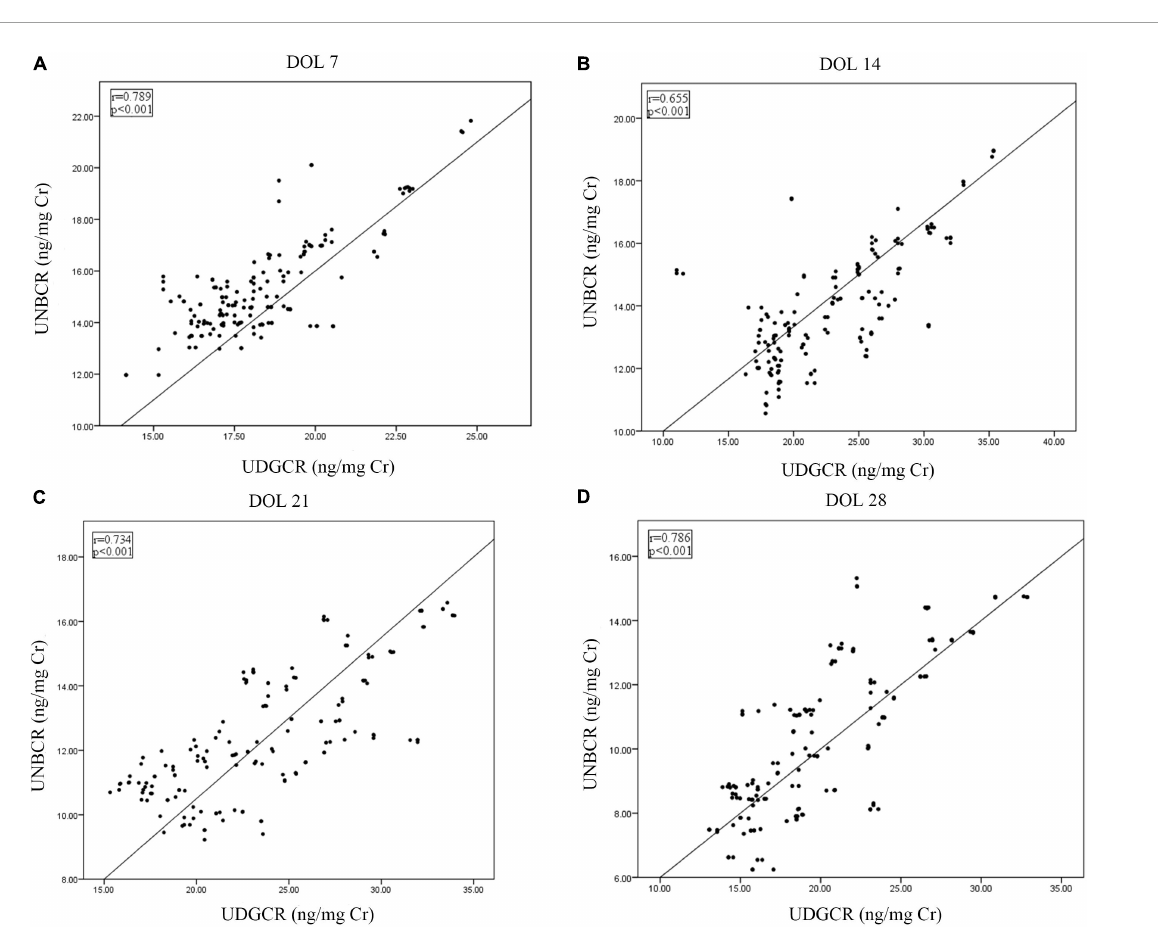
BPD. We also utilized ROC curves to determine the optimum predictive cutoff values of urine 8-OHDG and NT-proBNP for BPD from DOL 7 to DOL 28. These results may help identify preterm infants with a high risk of BPD early and provide effective prevention and treatment